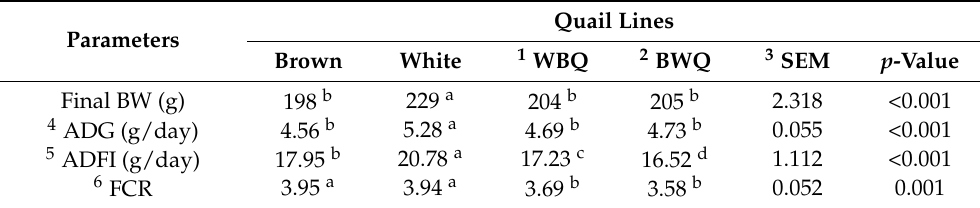
Table 3. Effect of crossing white and brown quail lines on growth performance traits. Parameters